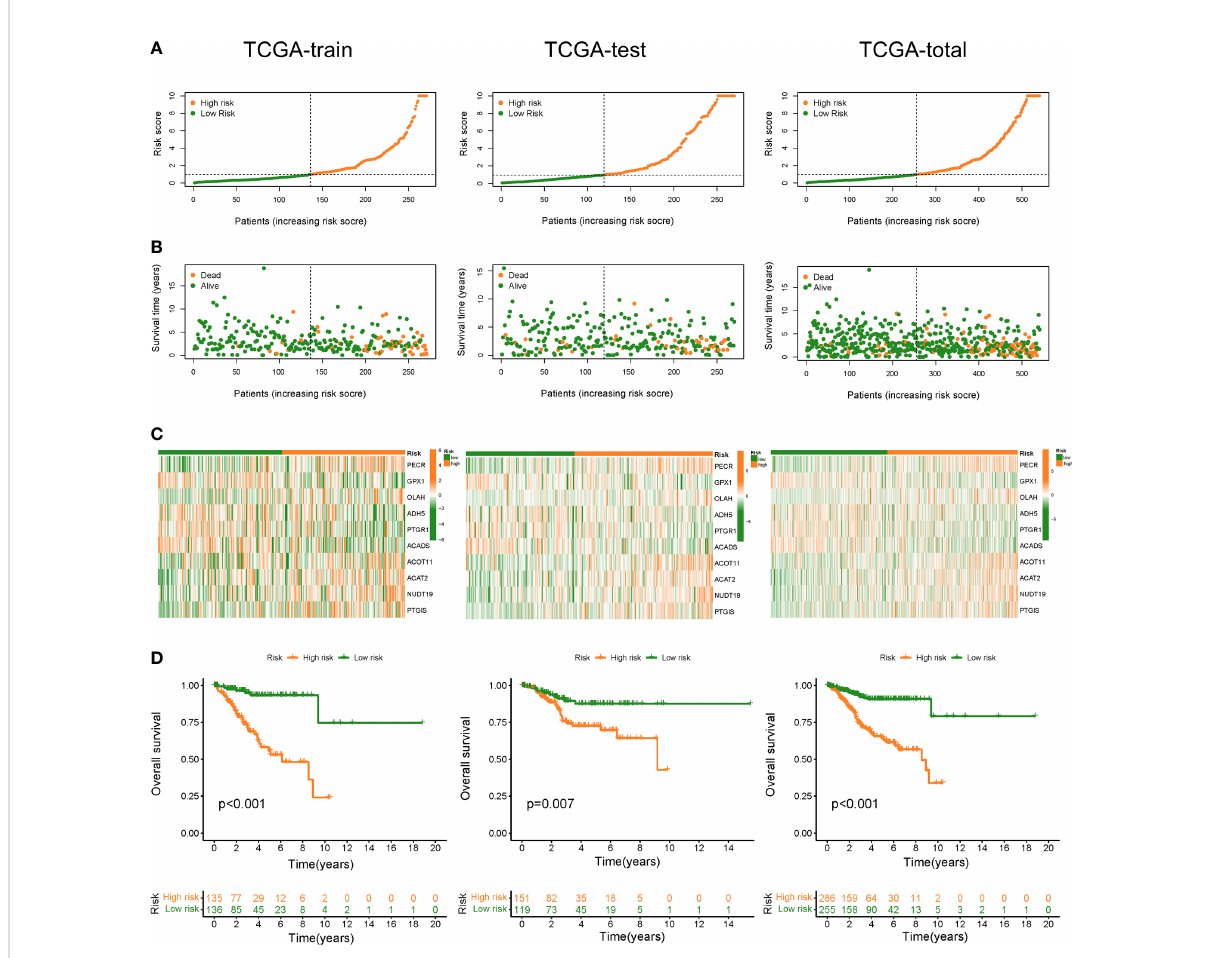
FIGURE 3 Construction and validation of FAMGs-based risk signature in TCGA train set, test set and total set. (A) Distribution of risk score in high- and low- FAMGs groups. (B) Dot pot of survival status with increasing risk score. (C) Heat map of FAMGs expressions in two groups. (D) K-M curve for patients ’ OS. FAMGs: fatty acid metabolism-related genes. K-M: Kaplan-Meier. OS: overall